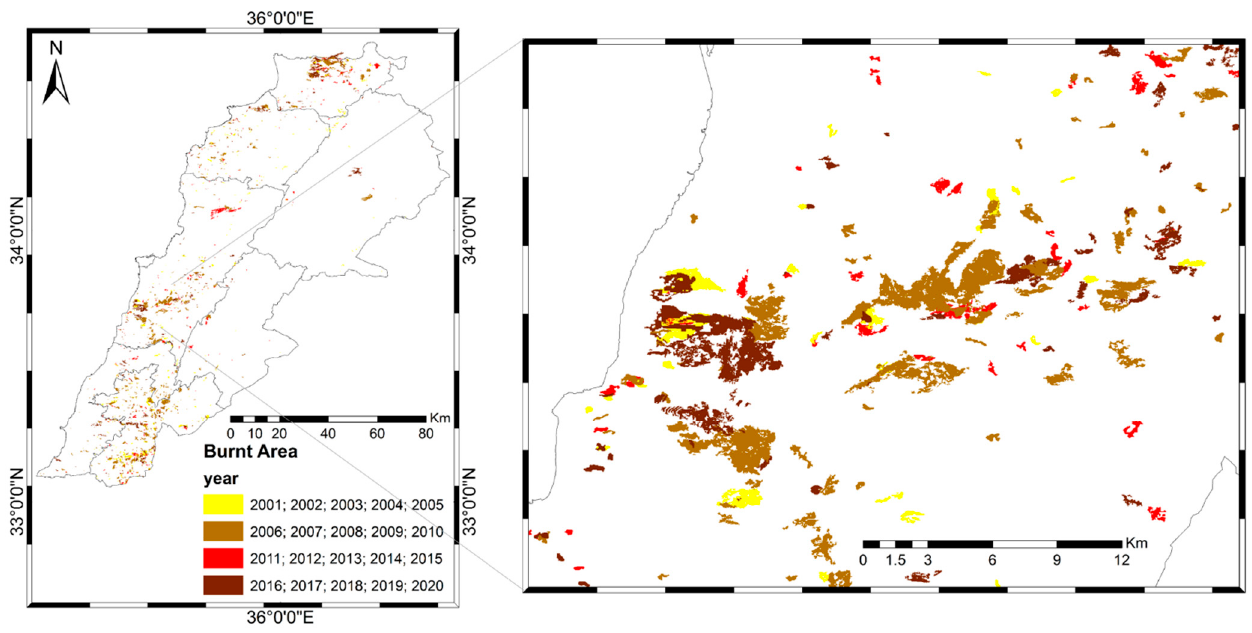
Figure 2. Location of fire events in Lebanon for the period 2001–2020, presented in intervals of 5 years (2001–2005: yellow, 2006–2010: light brown, 2011–2015: red, and 2016–2020: dark brown). Table 2. Burnt area (BA 10 3 ha) and percentage of BA per year, per governorate and vegetation type for Lebanon for the period